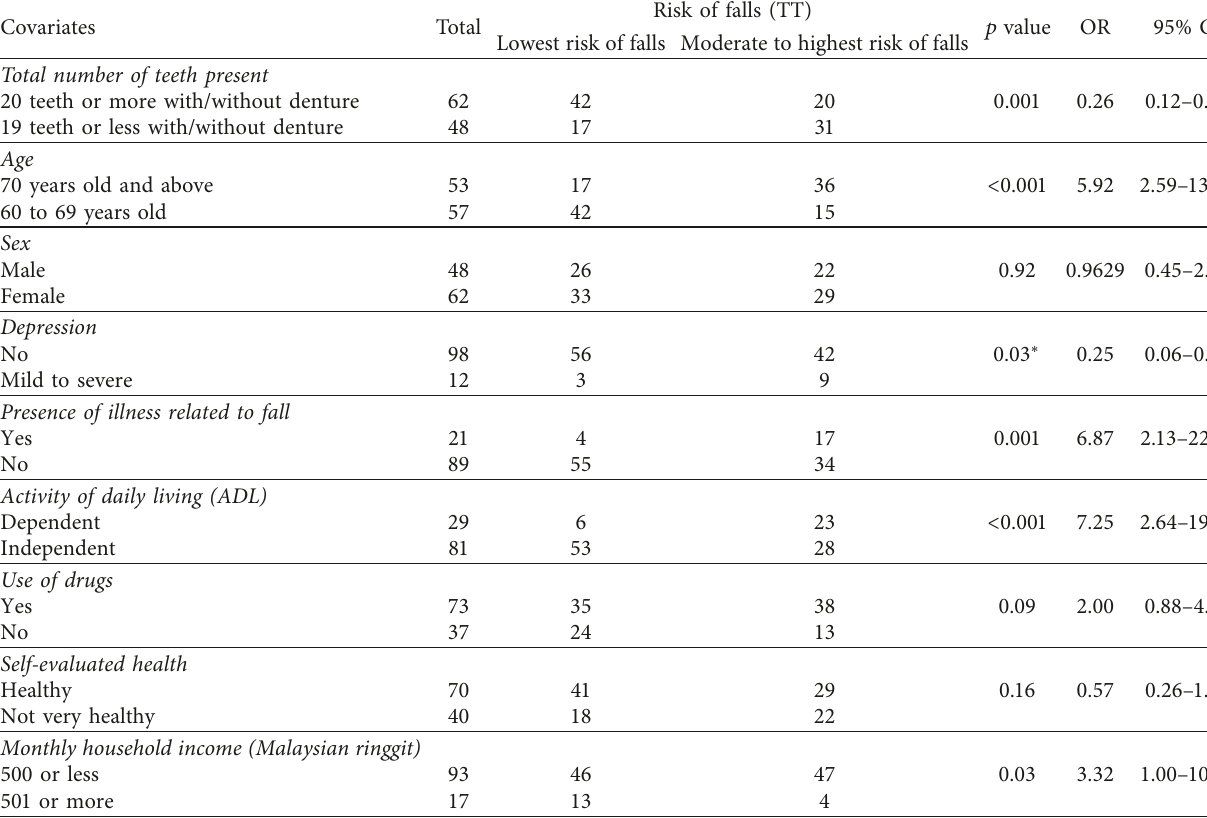
Table 2: Univariate associations of the number of teeth present and covariates with risk of